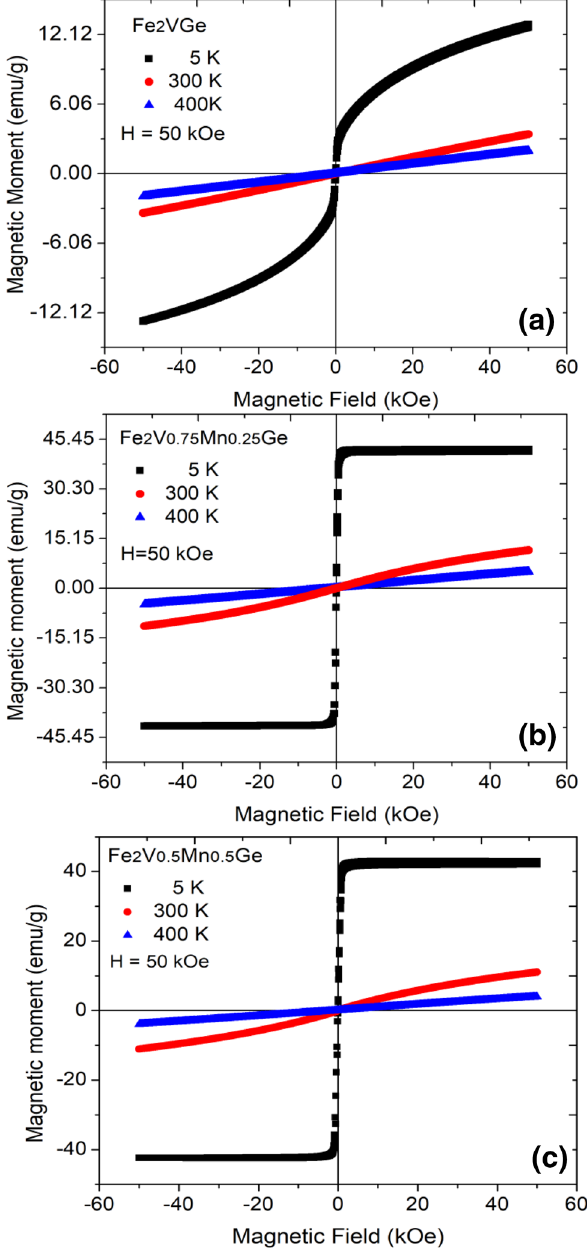
Fig. 7 (M-H) graphs of Fe kOe magnetic field and at 5 K, 300 K, and 400 K